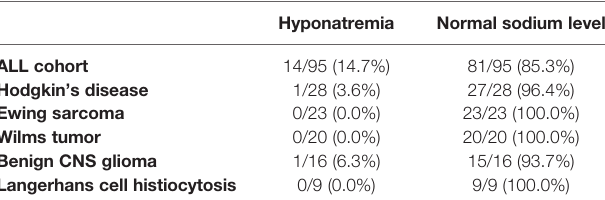
TABLE 3 | Difference between ALL patients and patients with other diagnoses studied in this study (Hodgkin ’ s disease, Ewing sarcoma, Wilms tumor, benign CNS glioma, and Langerhans cell histiocytosis) regarding occurrence of hyponatremia during induction